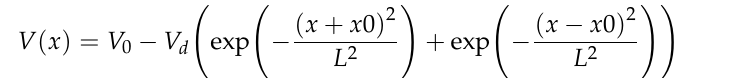
Figure 1. Conventional Overdamped Bi-stable Stochastic Resonance Model. ( a ) Model terminology and ( b ) particle perturbation by the force f ( c ) particle perturbation by the force f and noise D in the general case. ( d ) Particle perturbation by the force f and the noise D when resonance is approached. The potential function of the UPSR model [50] is shown below.